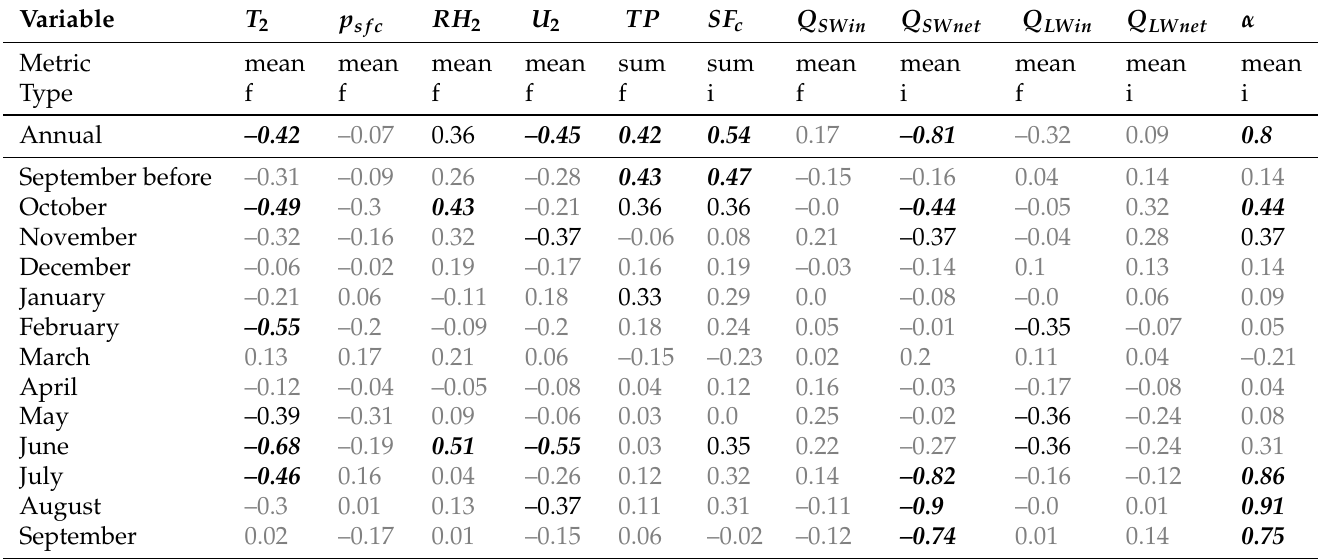
Table 4. Spearman’s rank correlation coefficients between monthly forcing (f) and intermediate (i) variables and annual glacier-wide climatic mass balance. Grey coefficients are not significant, normal font denotes significance level 0.05 and bold and italic fonts significance level 0.01. The aggregation metrics to calculate annual and monthly values are displayed in the second